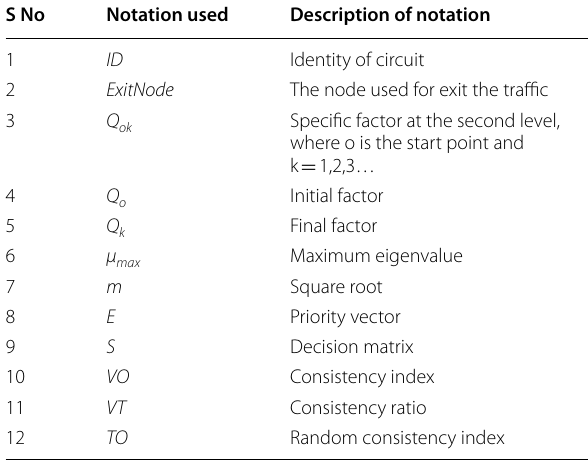
Table 1 Notations used in this